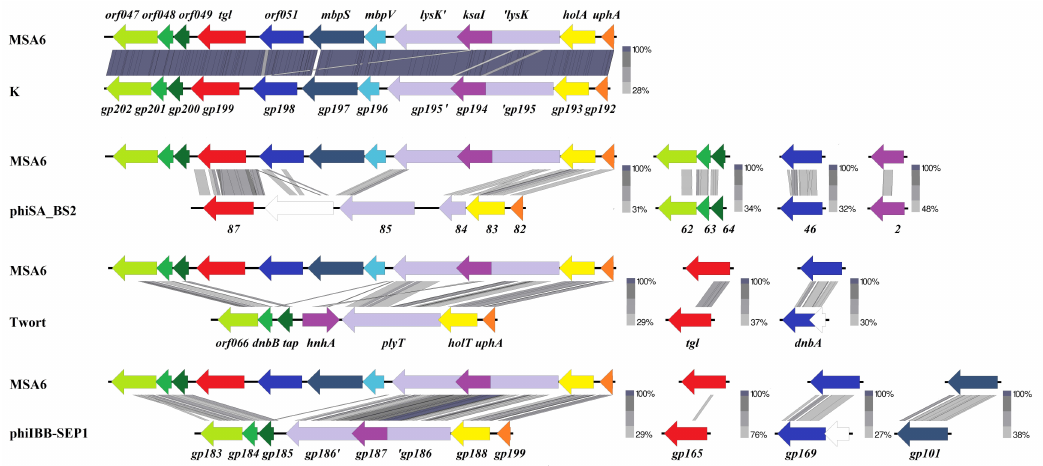
Figure 8. Similarities and di ff erences in the organization of genome regions containing lytic modules and tgl gene homologs in the genomes of kayviruses (MSA6 and K, GB acc no. JX080304 and KF766114, respectively) and representatives of Baoshanvirus (phiSA_BS2, GB acc no. MH028956) Twortvirus (Twort, GB acc. no. MT151386), and Sepunavirus genus (phiIBB_SEP1, GB acc. no. NC_041928) of Twortvirinae. Genes encoding homologous proteins are marked by similar